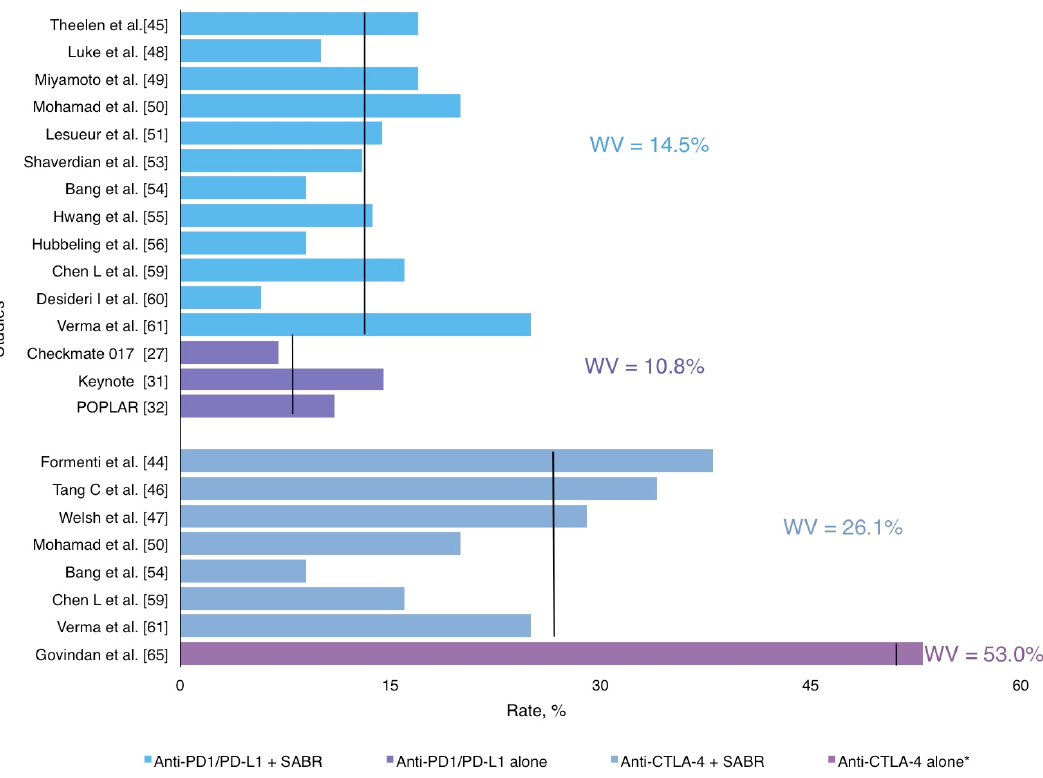
Figure 5. Grade ≥ 3 Adverse Events in SABR and ICI combination Figure 5. Grade ≥3 Adverse Events in SABR and ICI combination treatment.